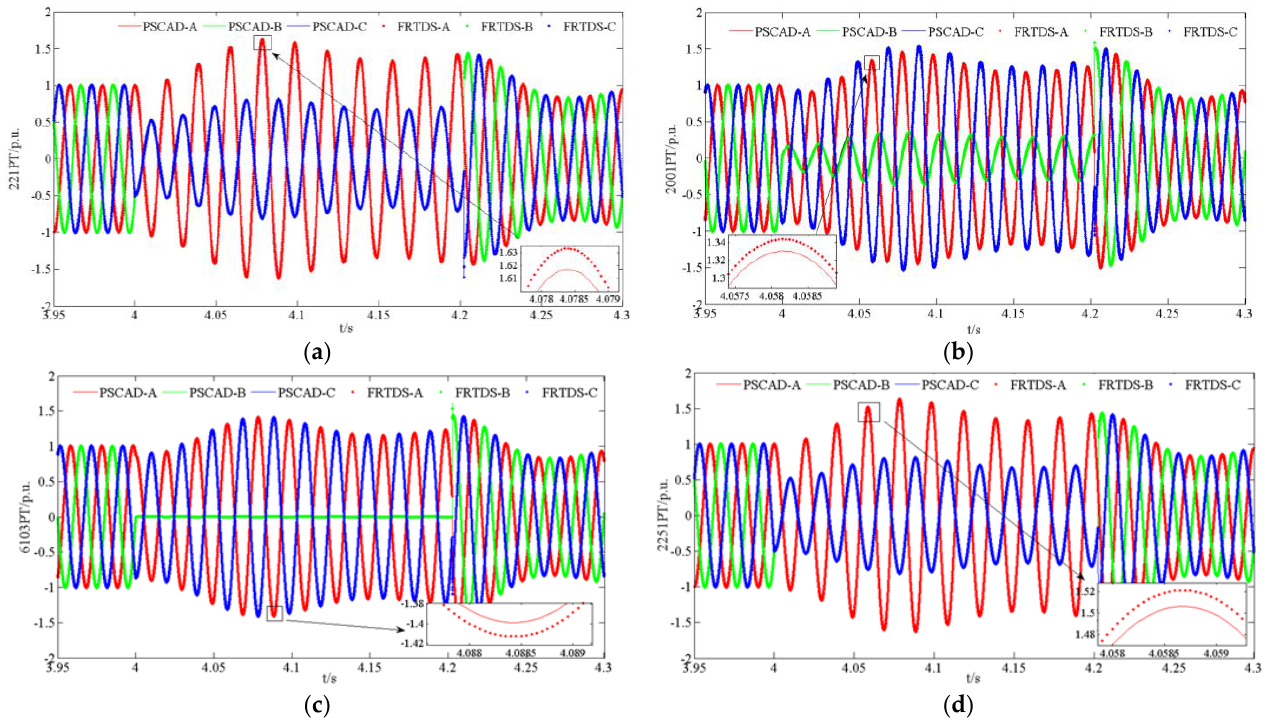
Figure 12. ( a ) The 220 kV I bus voltage waveform; ( b ) the 20 kV bus voltage waveform; ( c ) the 6 kV bus voltage waveform; and ( d ) the 2251-line voltage waveform.